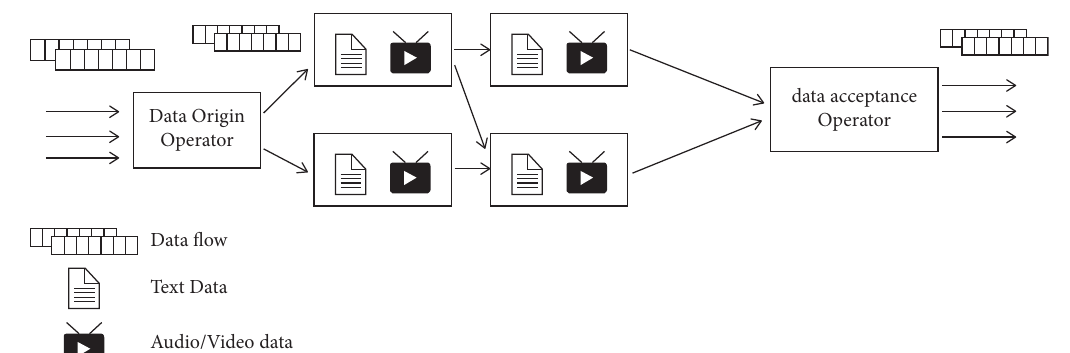
Figure 1: The situation of big data source and volume in development.